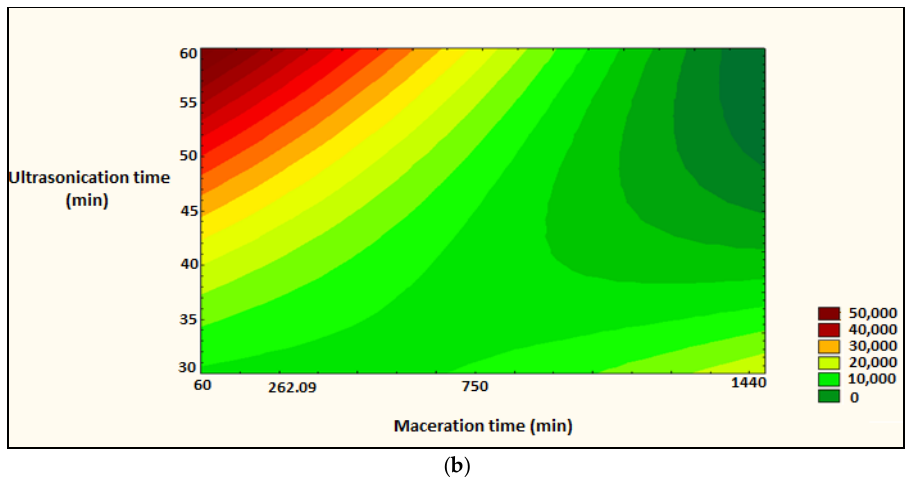
Figure 5. Surface plot and iso-response curve of polyphenols as a function of the two factors maceration time and ultrasonication time, ( a ): surface plot; ( b ): iso-response curve. The maximum accuracy is obtained for a desirability close to 1. Prediction of optimal conditions was: maceration time: 60 min, and ultrasonication time, 60 min, and predicted polyphenol content is 4.667 × 10 4 µ g Gallic Acid Equivalent (GAE)/g of extract (Figure 6).